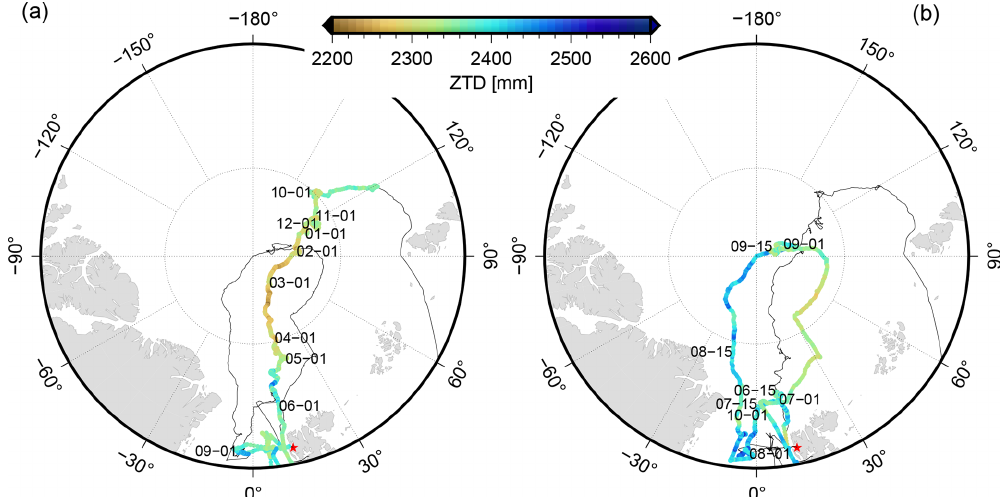
Figure 6. Ship track with hourly ZTD values (color coded according to the ZTD); panel (a) shows the ZTD series for August 2019 to 5 June 2020, panel (b) shows the ZTDs for 6 June to 3 October 2019; selected time stamps are added; the red star marks Ny-Ålesund.